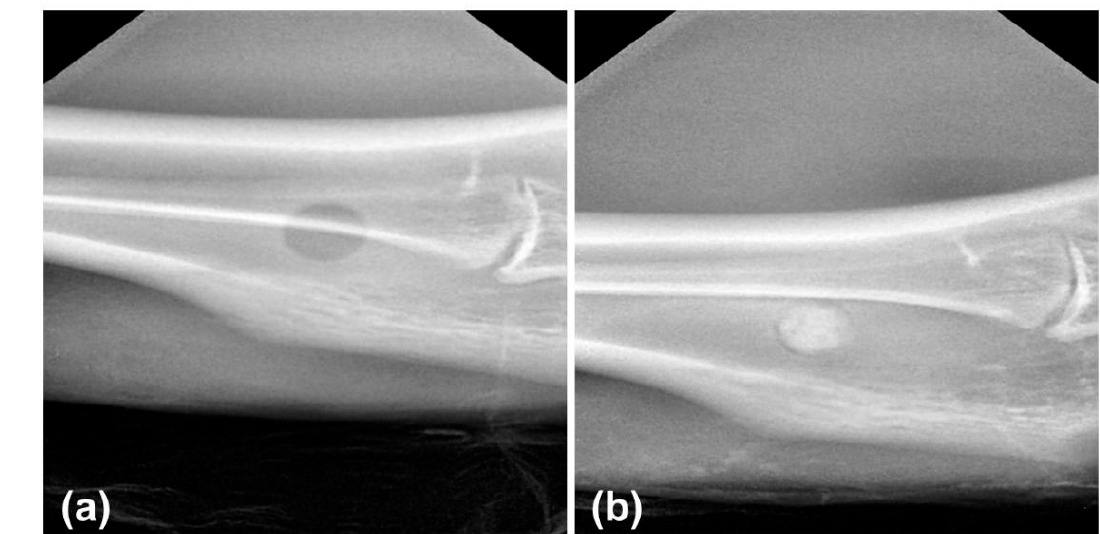
Figure 1. X-ray images of the defect in the animal of the control ( a ) and experimental group ( b ) after surgery.